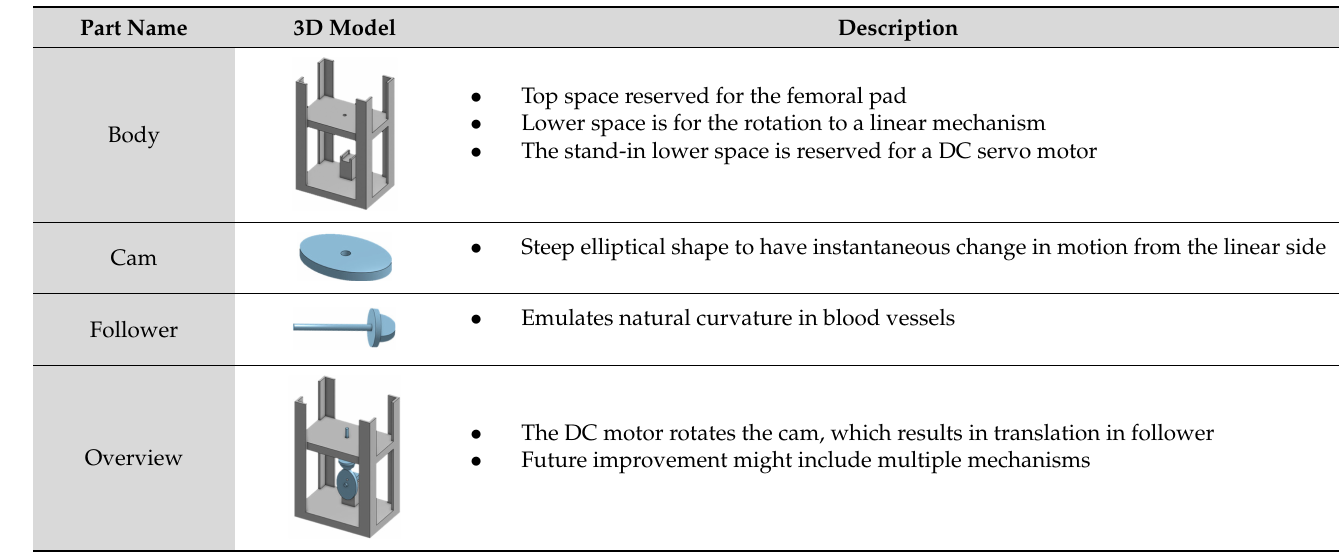
Table 4. Design of the cam and follower mechanism.